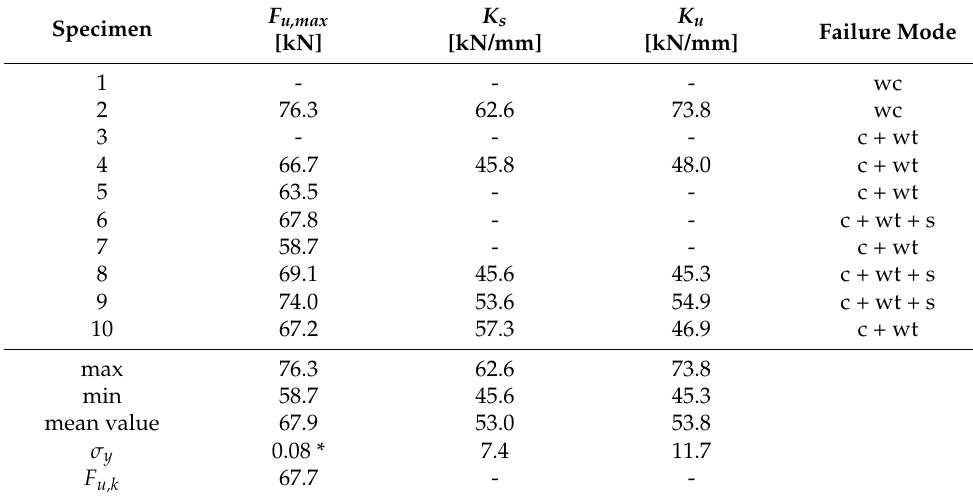
Table 3. Failure load and stiffness parameters for experimental series clc8240.